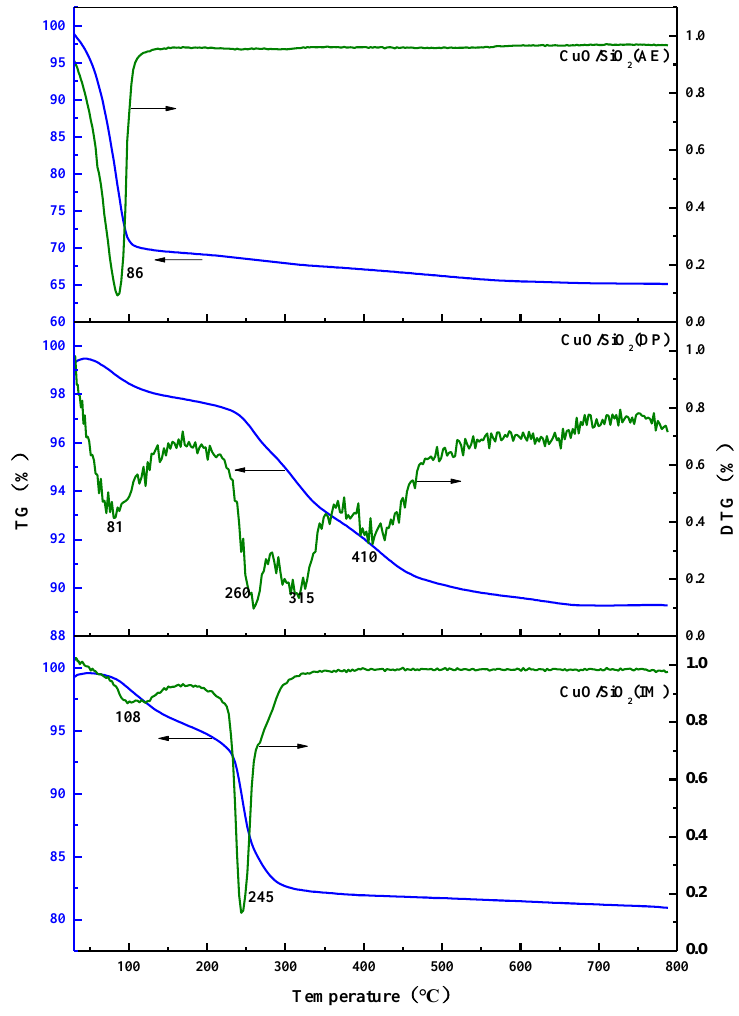
Figure 5. TG-DTG profiles of CuO / SiO 2 catalysts.